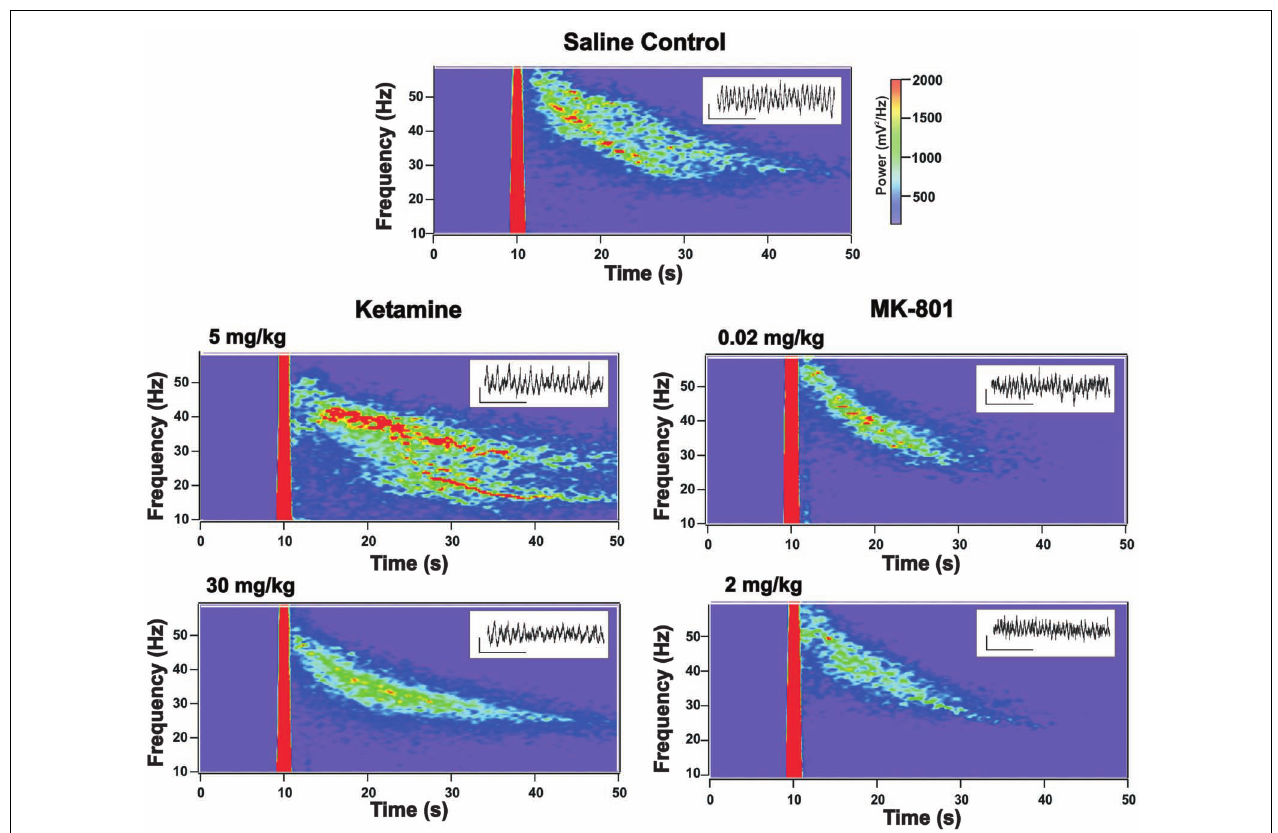
peak frequency (see Figure 2 ) and in the power in the (40–50Hz) band, which is almost absent in slices from drug treated mice 5–10s following KA application. 5mg/kg ketamine treatment also appears to show a slight decrease in the higher-frequency elicited response, while the response at lower frequency bands appears elevated (not significant). MK-801 treated mice show a trend toward reduced power but no change in peak frequency (see Figure 2 and text). Insets provide representative examples of GBO signal traces recorded from acute slices from mice in each treatment group (scale bar for insets: x = 200ms, y = 50 µ